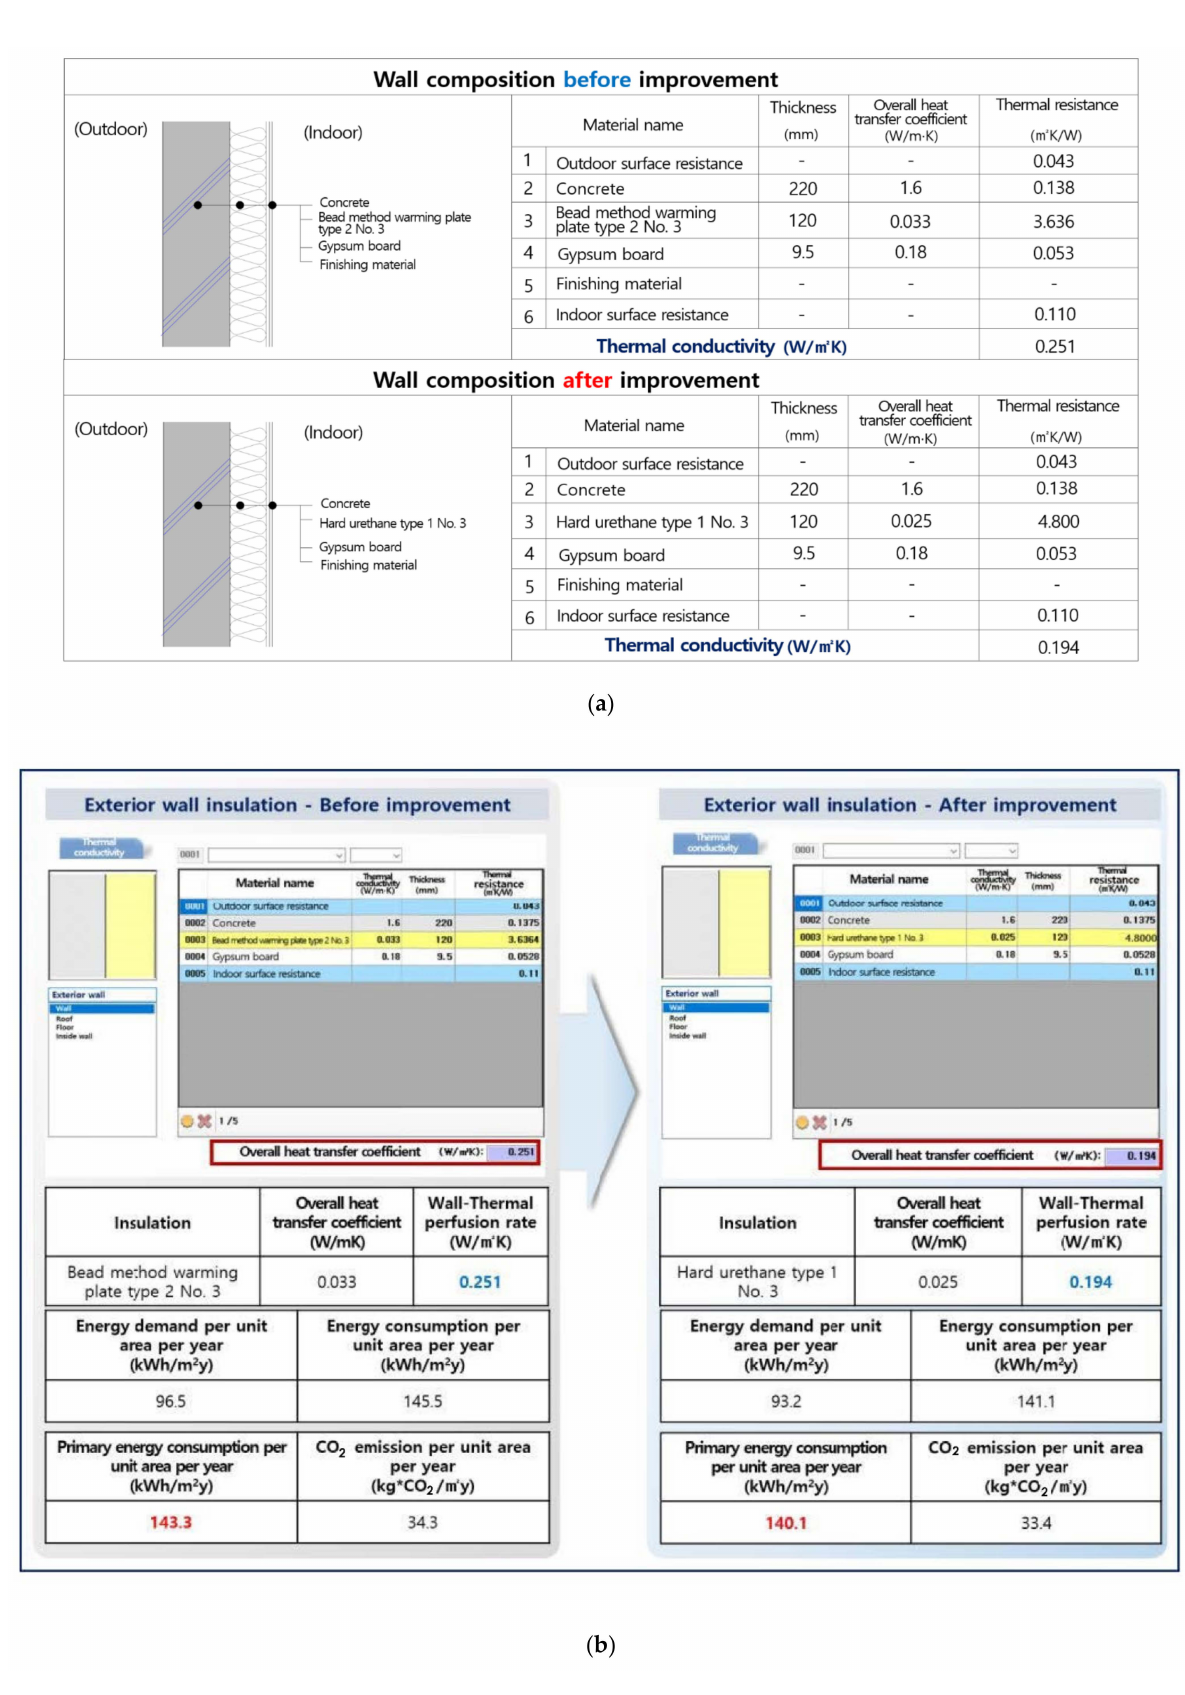
Figure 7. ECO2 input for P complex. ( a ) Composition of exterior wall; ( b ) Exterior wall